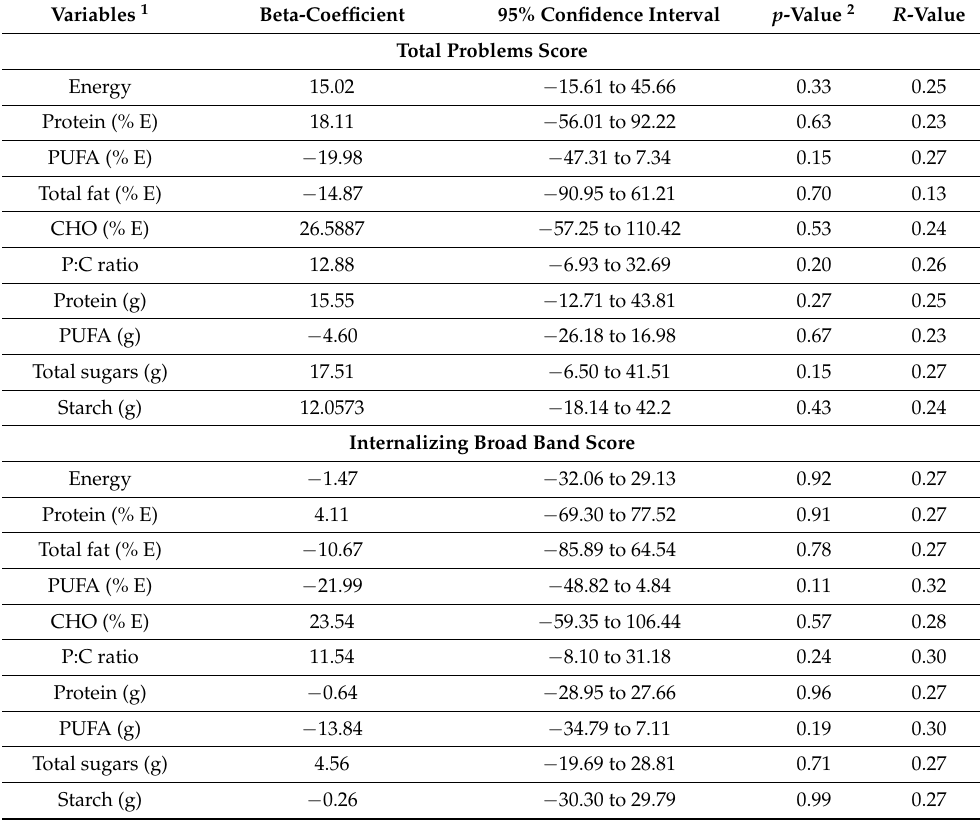
Table 4. Association of maternal dietary composition during pregnancy with child behaviour outcomes up to age 4 years ( n =